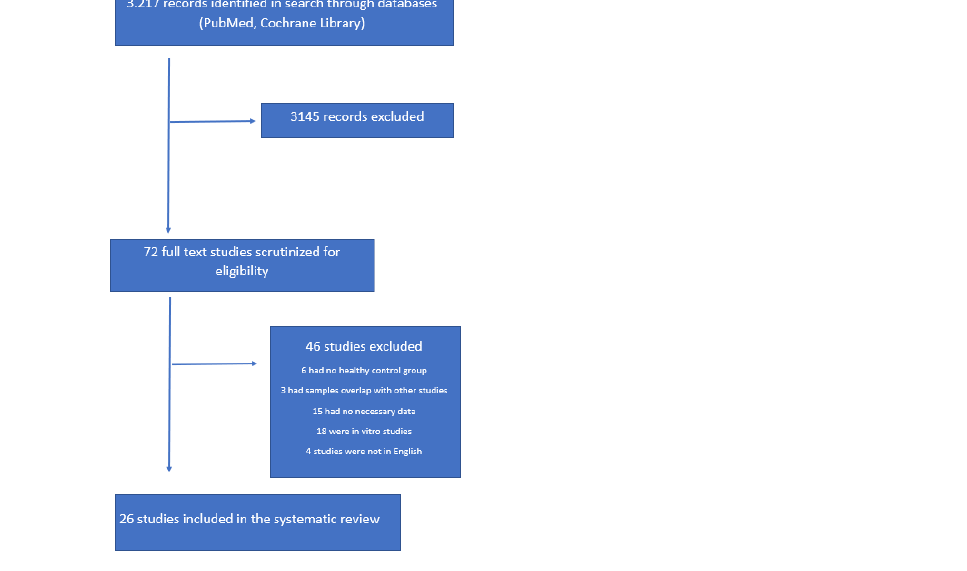
Figure 4. Prisma flowchart of the literature search according to eligibility and exclusion criteria that were set. 4.5. Data Collection and Eligibility Criteria Studies were selected when they provided information on peripheral cytokine con- centrations in PD patients and healthy controls and when they met the following criteria: (1) case control studies, (2) languages being limited to English, and (3) full study. All in vitro studies that reported stimulated or unstimulated levels of cytokines were excluded from the analysis.